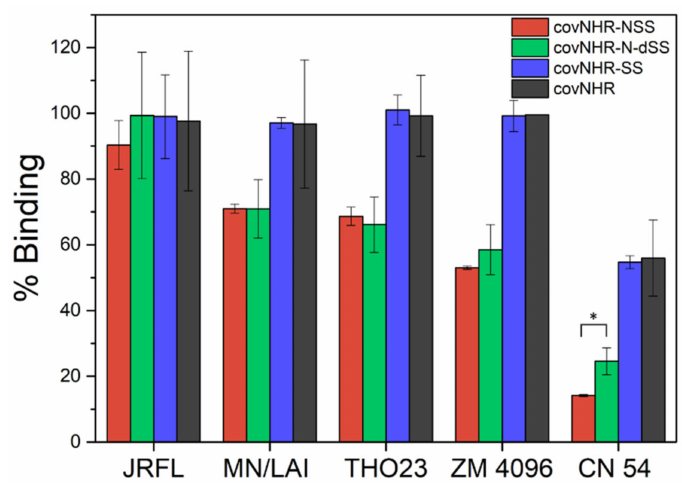
Figure 5. Binding of covNHR miniproteins to different soluble Envs (Table S1) measured by ELISA. Miniproteins binding to Env was detected using anti-6X Histag Ab as primary antibody. Background binding was measured without Env and subtracted from the data; 100% positive control was mea- sured with wells directly coated with a His-tagged Env. Data correspond to mean ± S.D. values of three independent measurements. * p < 0.05, difference between covNHR-N-dSS and